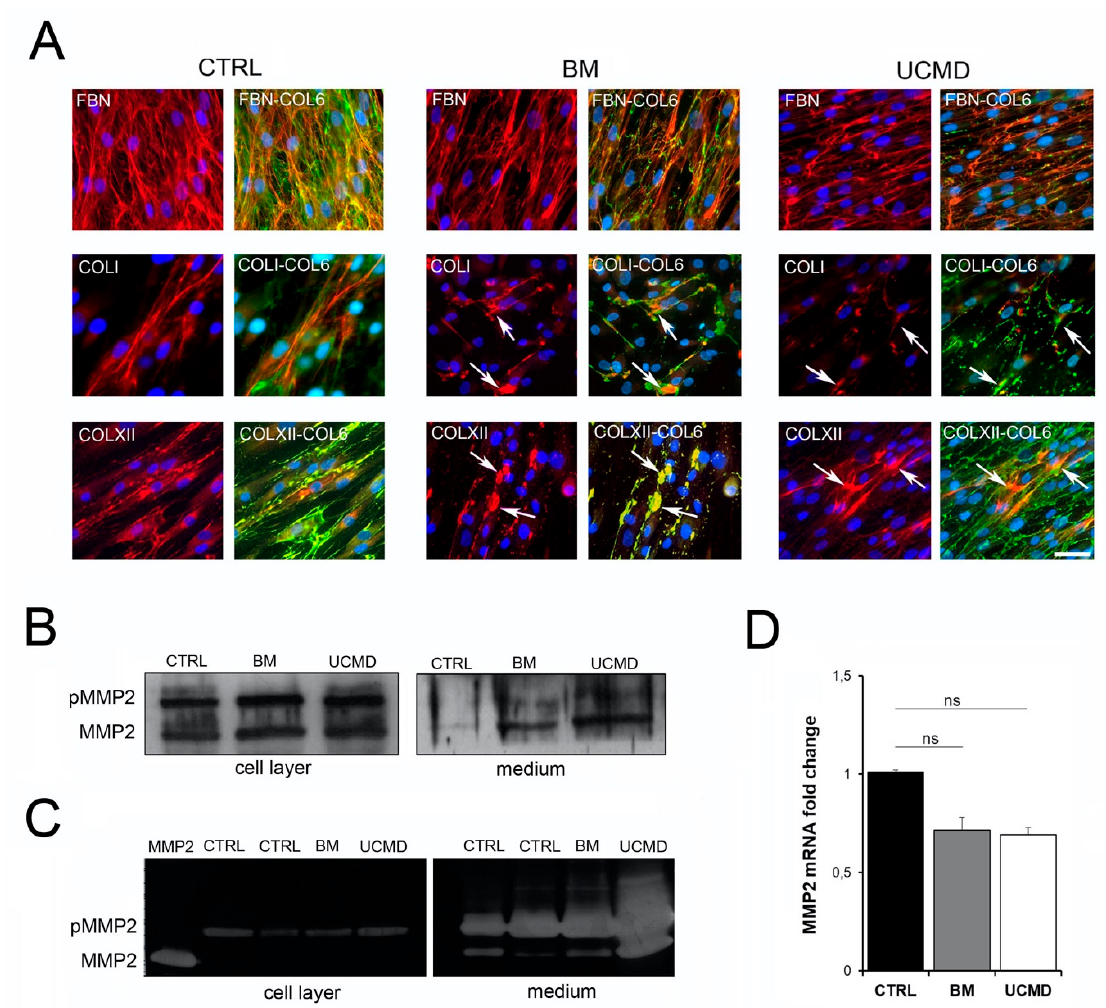
Figure 4. ( A ) Immunofluorescence microscopy of fibronectin (FBN), collagen type I (COLI), collagen type XII (COLXII), and their merge with collagen VI (COL6, green) in control (CTRL), BM, and UCMD long-term cultures. Note the longitudinal pattern of fibronectin fibrils in BM and UCMD samples, when compared with the intertwined pattern in normal cells. In both BM and UCMD cultures, collagen I and collagen XII staining, and their merge with collagen VI, show the presence of protein aggregates (arrows). Nuclear staining, DAPI. Scale bar, 50 μ m. ( B ) Western blot analysis of active MMP2 (MMP2) and pro-MMP2 (p-MMP2) in control (CTRL), BM, and UCMD cell layer and medium showing an increase of the MMP2 active form in the conditioned medium of both patient cultures. ( C ) Gelatin zymography of cell layer and conditioned medium of two controls (CTRL), BM, and UCMD patients. MMP2 was loaded at a concentration of 50 mg/mL as a reference to the mobility of the active form. Note the increase of both pro-MMP2 (p-MMP2) and MMP2 activity in the UCMD medium. No obvious differences are detectable in BM cell layer and medium when compared with two controls (CTRL). ( D ) MMP2 mRNA analysis in UCMD and BM cells showing no significant (ns) differences with respect to control (CTRL) cells. Data represent mean ± SE of three independent experiments.